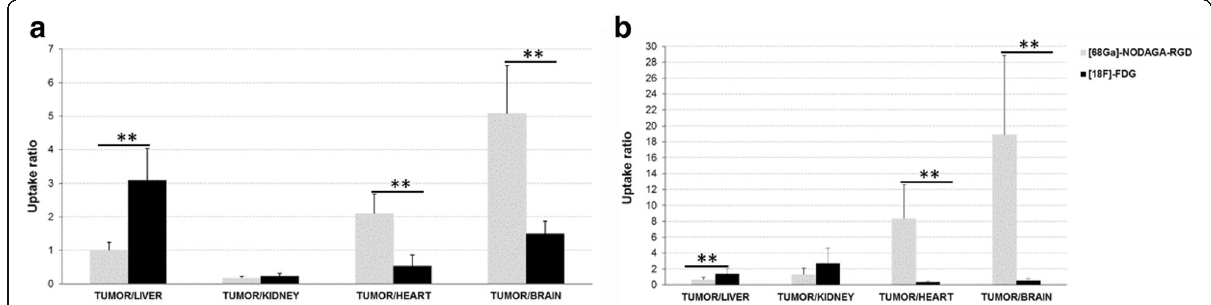
Fig. 3 Comparison of tumor-to-organ ratios for activities measured during the 2 nd hour with PET recording ( a ) and gamma counter ( b ) between 68 Ga-NODAGA-RGD and 18 F-FDG in 17 xenograft mice (** p < 0.001 for 68 Ga-NODAGA-RGD vs. 18